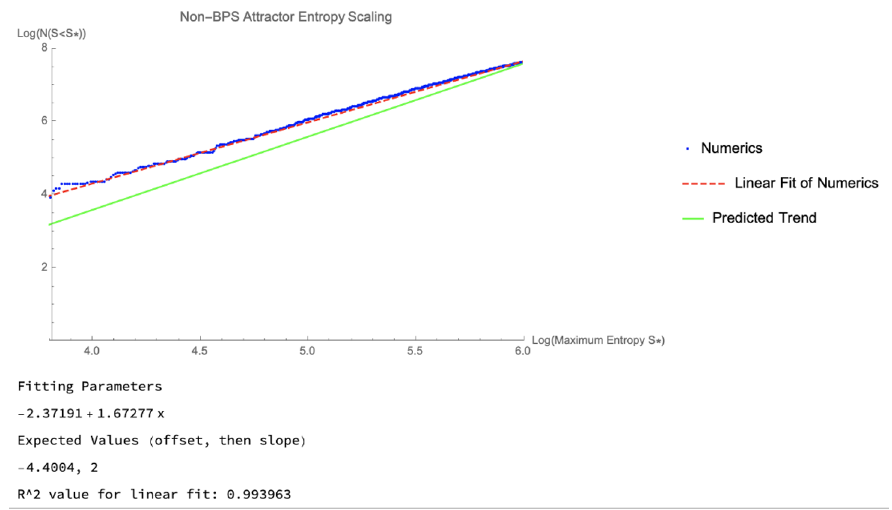
Figure 3 . Similar to (cid:12)gure 2, but on a log-log scale. Unlike in (cid:12)gure 2, we have not added a y -intercept to the theoretical prediction. This causes the theoretical prediction to be systematically smaller than the numerical results, thanks to the large number of attractors that were found with small entropy, which are not governed by our large-entropy prediction. However, one can see in this (cid:12)gure that the theoretical prediction is catching up to the numerics, as the total number of attractors begins to overwhelm the number of attractors with small entropies. At the same time, one can discern a trend that is dragging the data down at large S (cid:3) , which is due to the fact that in this regime we have not found all of the attractors.